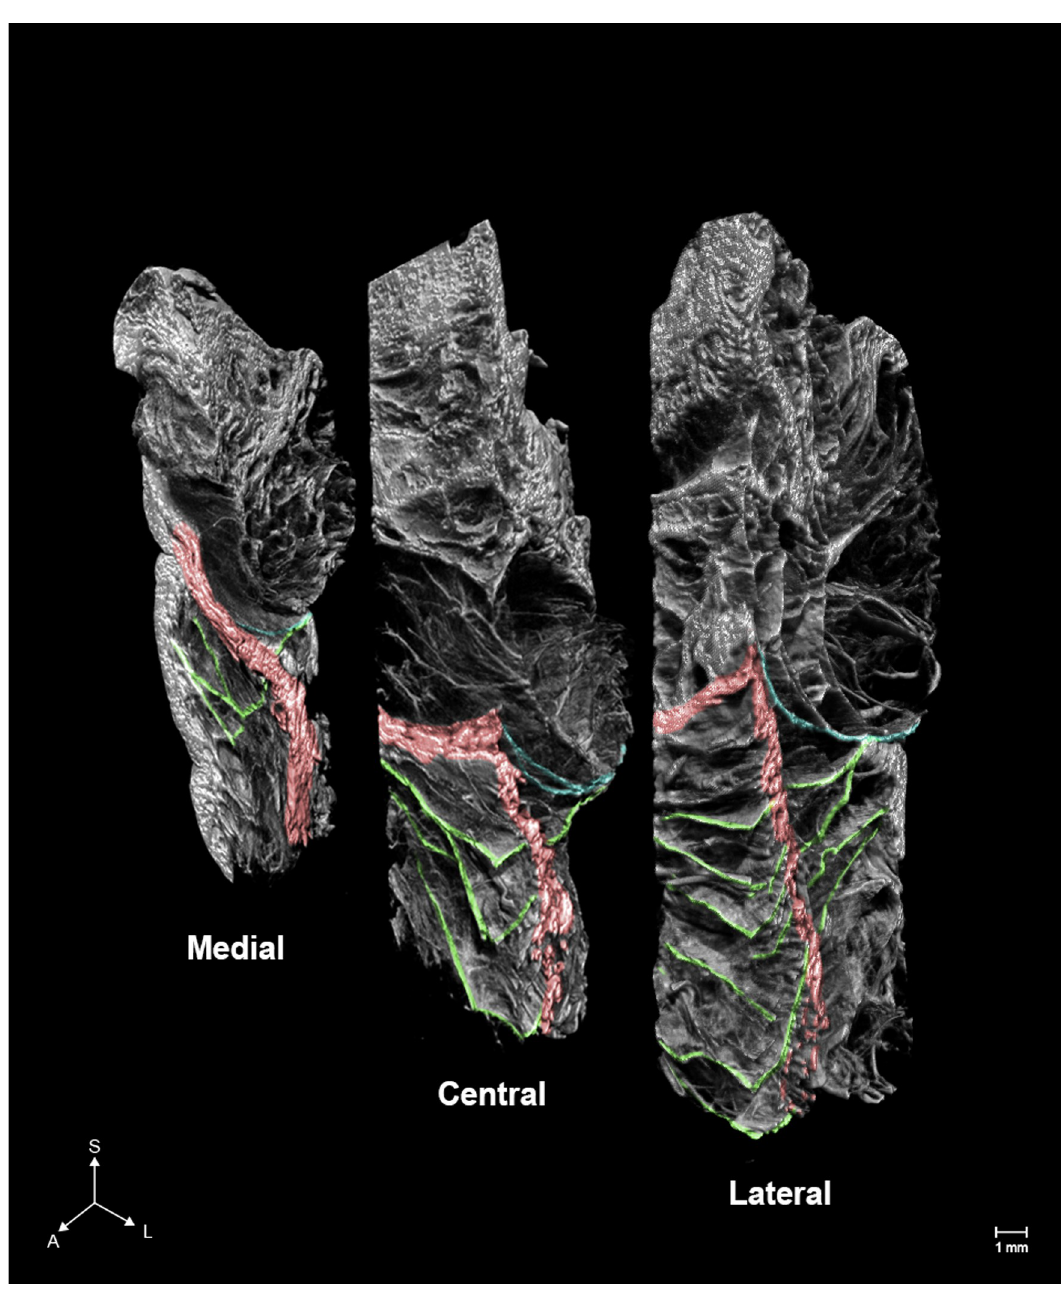
Fig 1. Micro-computed tomography (microCT) images of the orbicularis retaining ligament (ORL). The number, complexity, and ambiguity of the fibers comprising the ORL increased anteriorly and laterally. Green, blue, and red indicate the ORL, the orbital septum and, the section of the orbicularis oculi. S, superior; A, anterior; L, lateral.